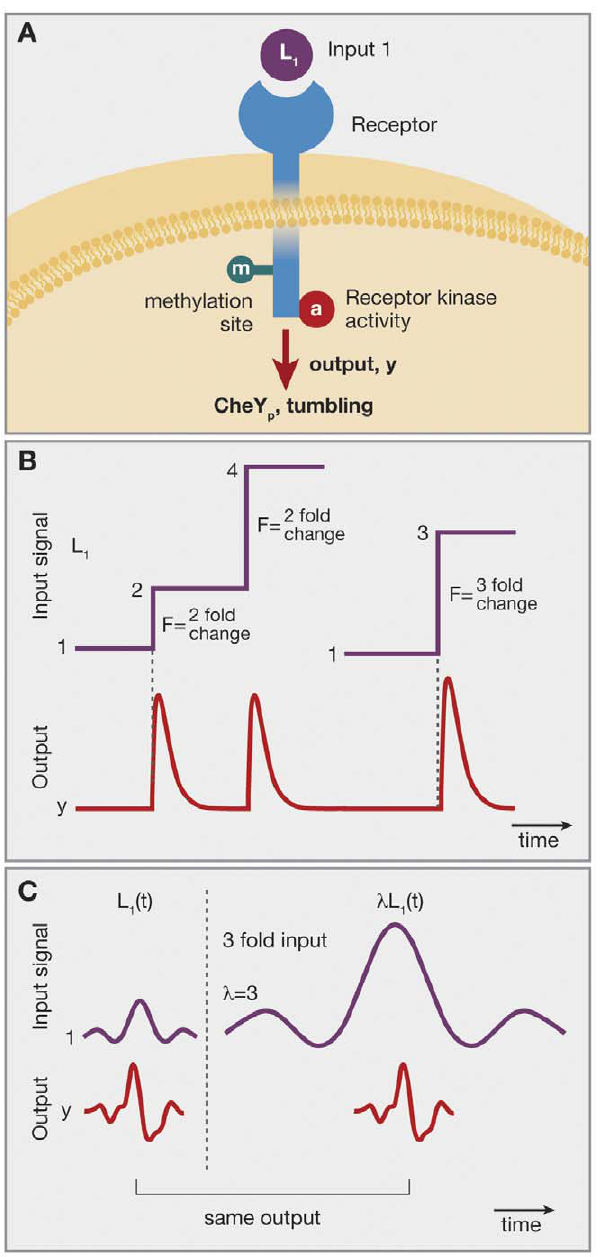
Figure 1. Fold change detection (FCD) in bacterial chemotaxis in the single input situation and its experimental test by Lazova et al. (A) The chemoreceptor Tar binds the ligand MeAsp (L 1 ). Its associated kinase activity is modified by methylation. The output is CheYp which lead to bacterial tumbles. (B) Analysis of Shoval et al of the Tu et al model of chemotaxis predicted that the system shows fold